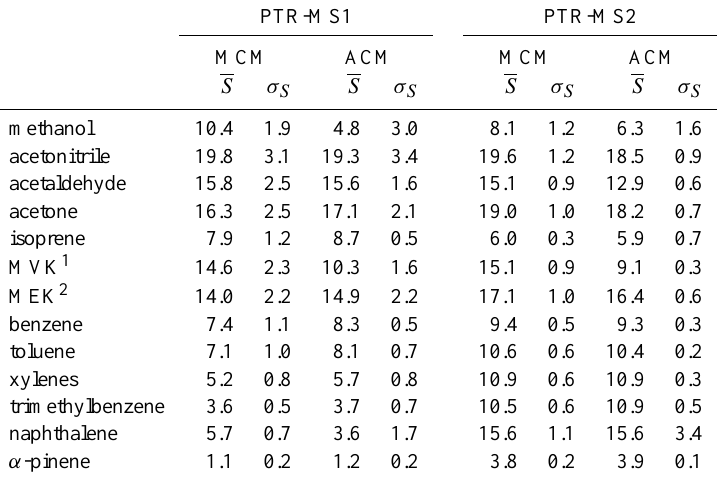
Table A1. Results of the PTR-MS calibration tests. “Manual calibration method” (MCM) refers to the system in which the calibration gas standard and zero air flows are controlled manually with a pressure regulator and needle valves (see Taipale et al., 2008, for details). “Automatic method” (ACM) refers to the calibration mixing units, in which the flows are controlled automatically with mass flow controllers. All parameters of the table are presented in the [ppbncps − 1 ] unit. S and σ S are the mean sensitivity and the standard deviation of the sensitivity,